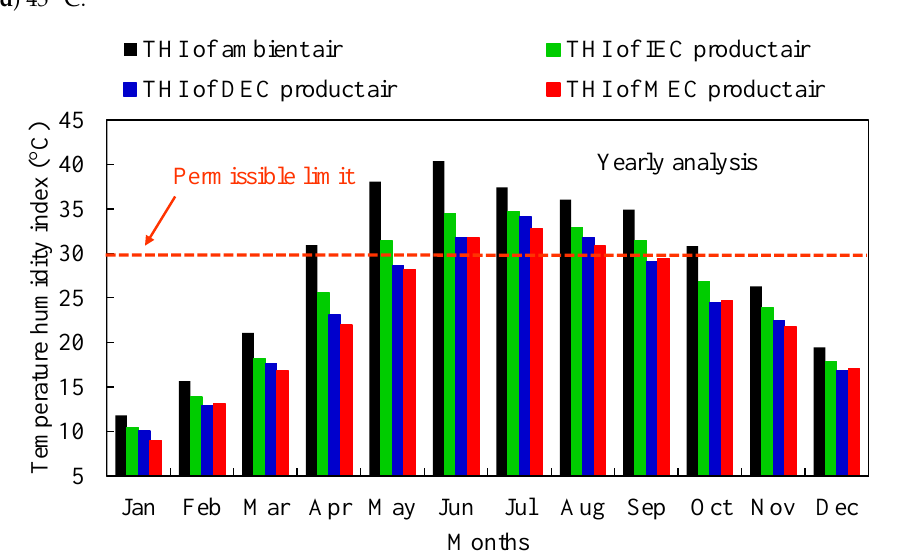
Figure 12. The sensible and latent heat production per poultry bird for ( a ) 18 ◦ C, ( b ) 30 ◦ C, ( c ) 40 ◦ C, and ( d ) 45 ◦ C.